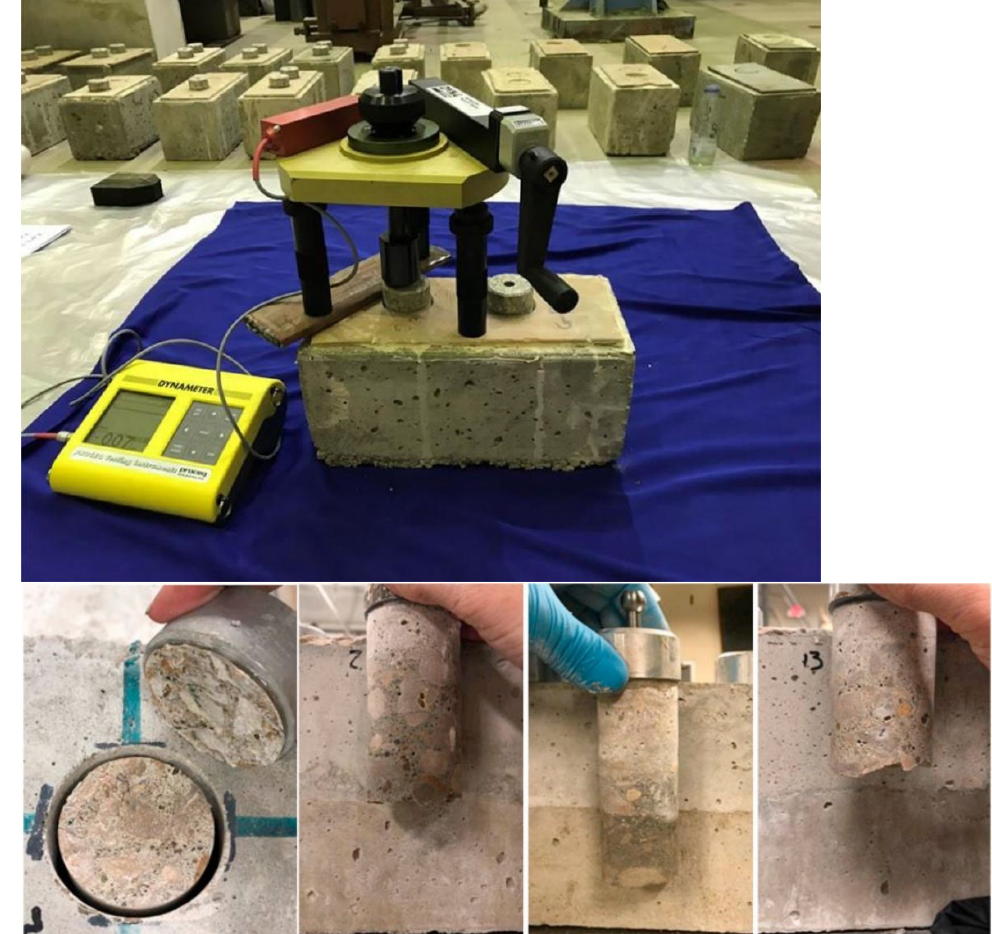
Figure 7. Tests for core pull ‐ put bond strength between repair materials and concrete substrate [56]. (Adapted and reprinted with permission from ref. [56], © 2020, Journal of Materials Research and Technology ).